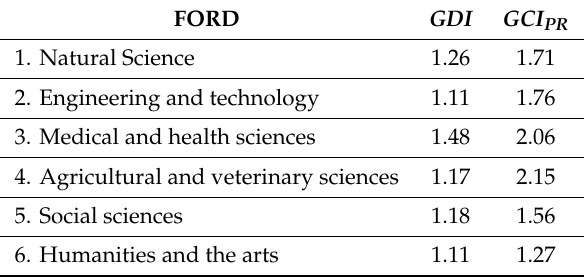
Figure 4. Proportions (%) of women in permanent positions and in grade A by main field of science. Table 10. 𝐺𝐷𝐼 e 𝐺𝐶𝐼 by main field of science (author’s elaboration of MIUR data, 2017). FORD 𝑮𝑫𝑰 𝑮𝑪𝑰 𝑷𝑹